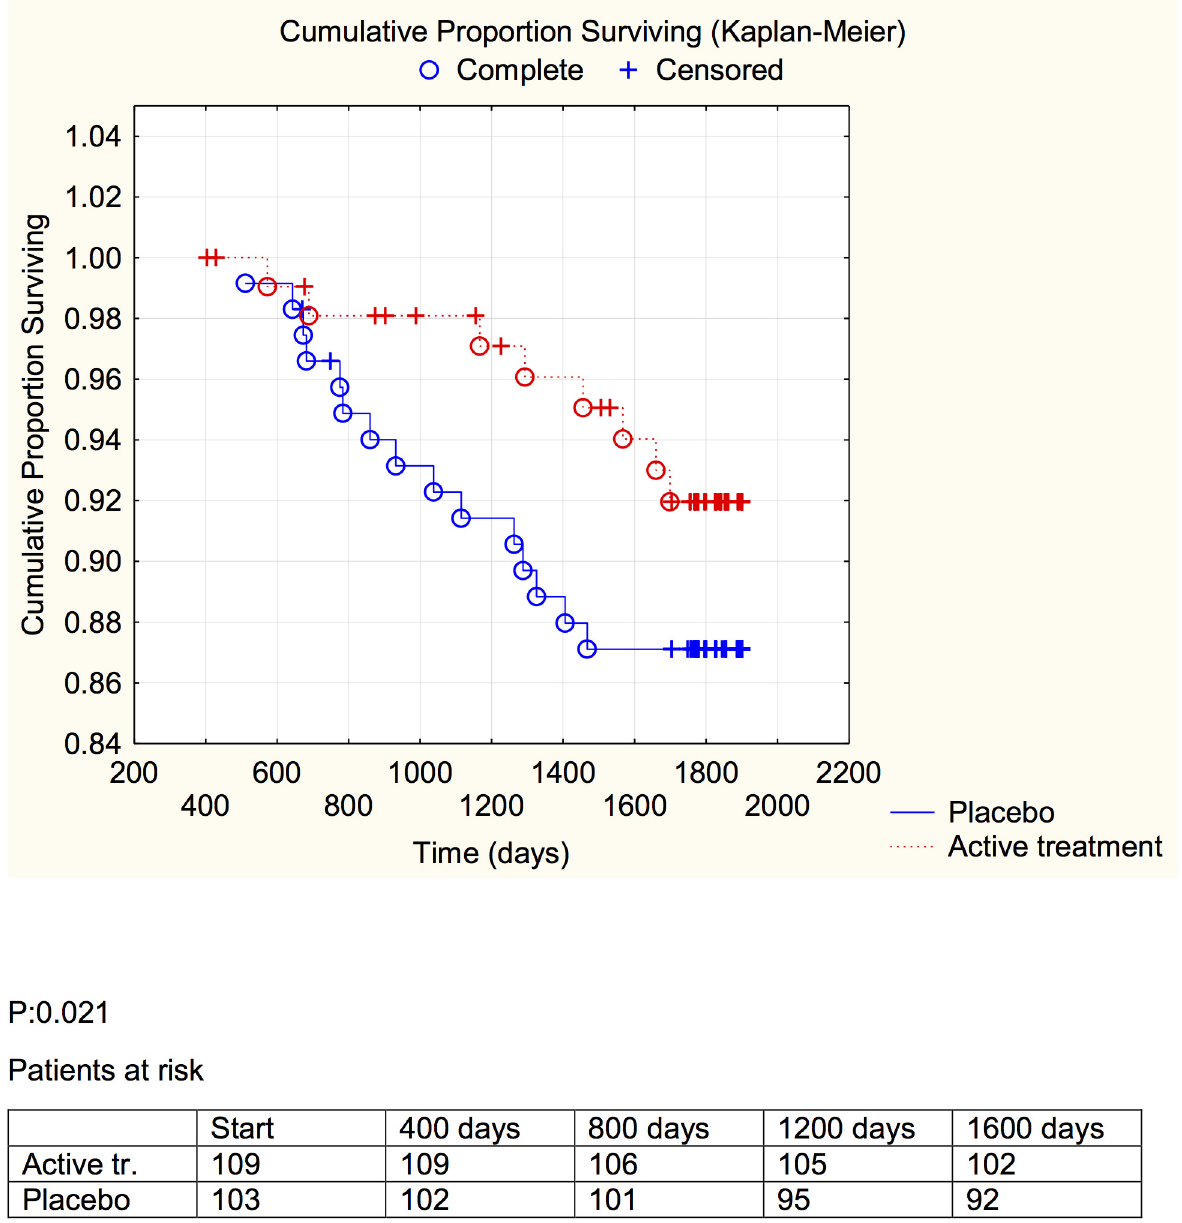
Fig 4. Distribution of cardiovascular mortality among those with a C-reactive protein concentration below median in those who received active supplementation of selenium and coenzyme Q10 combined versus placebo during follow-up of 5.2